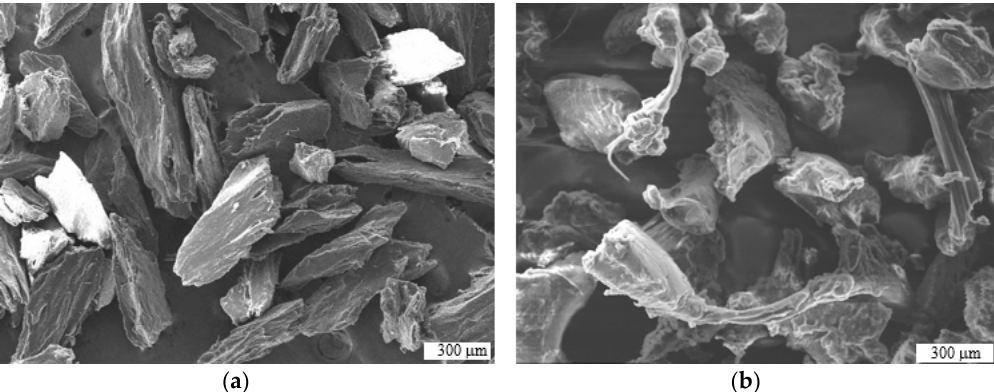
Figure 5. The SEM image of the powders sieved down to <300 µ m. ( a ) Demineralized bone particulates and ( b ) polycaprolactone (PCL) powders. Scale bars represent 300 µ